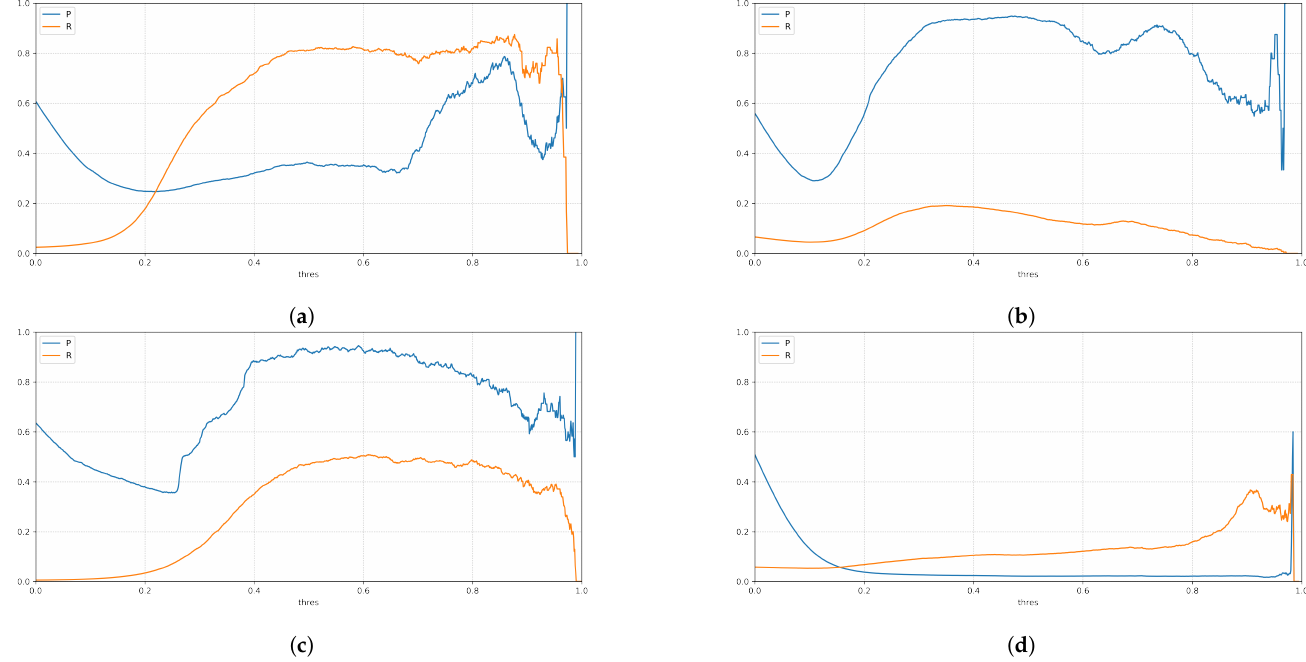
( thres ) and Recall R ( thres ) for four exemplary motifs. ( a ) Motif of a fully automatic coffee Figure 5. Precision P motif motif n n machine (’GeLaP’: household 05; device: 003). ( b ) Motif of a washing machine (’GeLaP’: household 05; device: 007). ( c ) Motif of a water pump (’GeLaP’: household 05; device: 008). ( d ) Motif of a television (’GeLaP’: household 05; device: